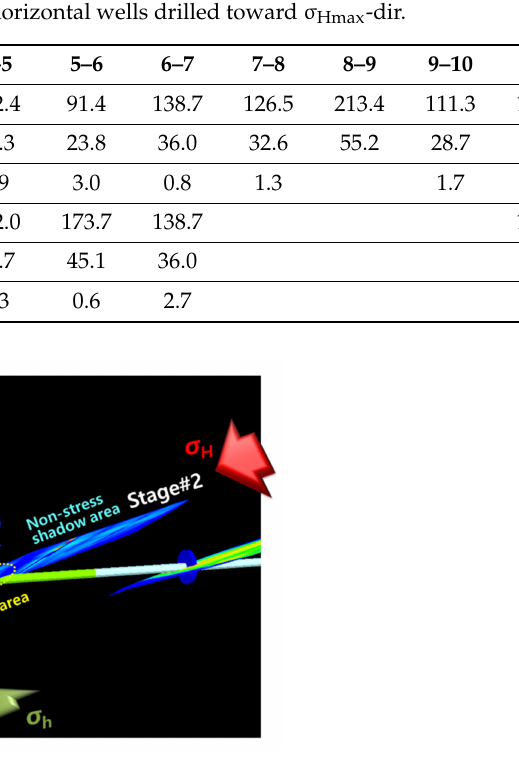
Figure 10. Stage #2 fracture affected by stress shadow due to stage #1